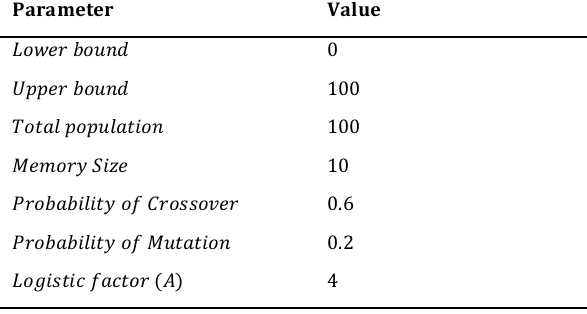
Table 2. Parameter values for proposed